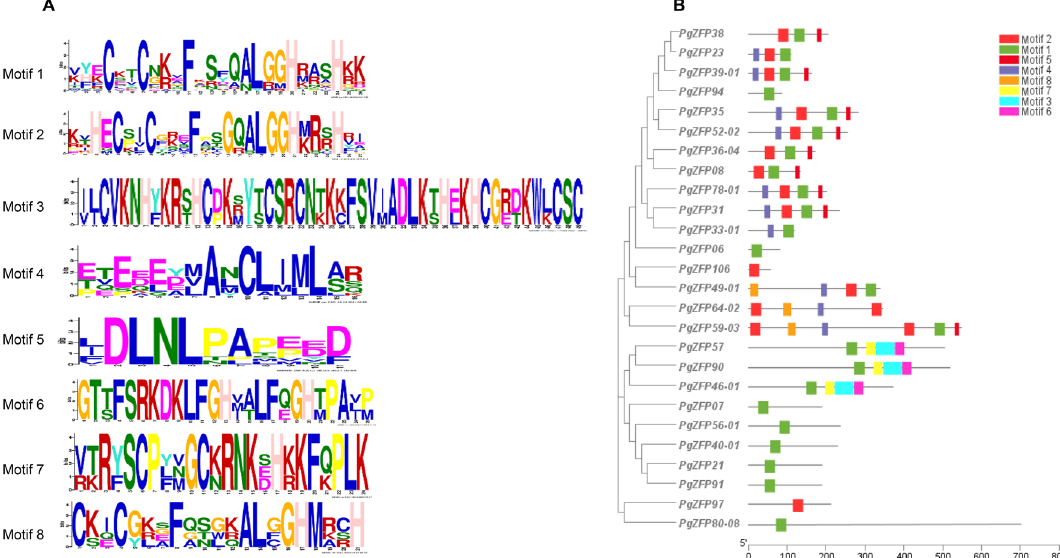
Figure 3. The conserved motifs and their distribution in the PgZFP genes. ( A ) Conserved motifs of PgZFP proteins. ( B ) Conserved motif distribution in the PgZFP proteins. The phylogenetic tree of the PgZFP proteins were constructed using the maximum-likelihood (ML) method.